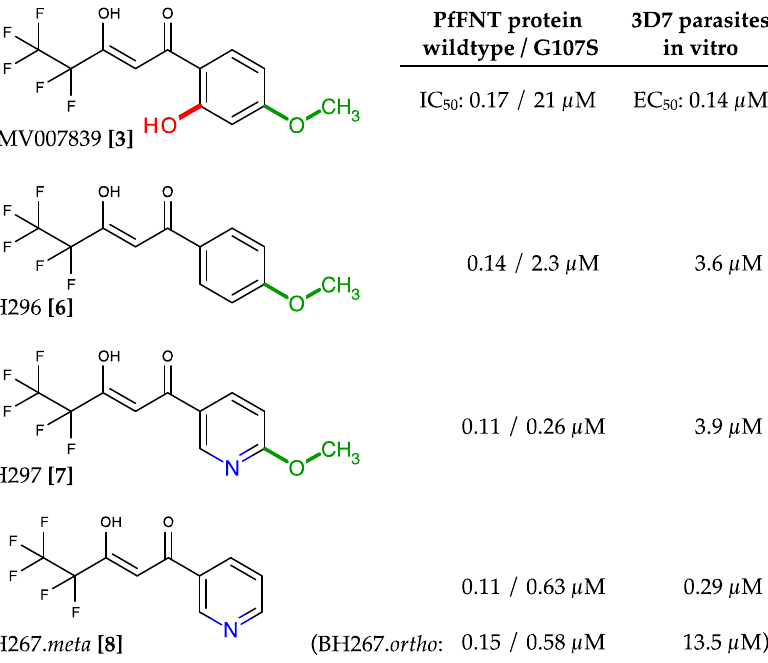
Figure 6. Development of PfFNT inhibitors with activity against the G107S resistance mutation. The clashing phenol hydroxyl and the methoxy moieties were successively removed, and nitrogen atoms were introduced into the aromatic to act as hydrogen bond acceptor sites. Eventually, with BH267.meta, a compound was generated exhibiting nanomolar efficacy on the PfFNT wildtype and G107S mutant protein, as well as in 3D7 P. falciparum parasite in vitro cultures.